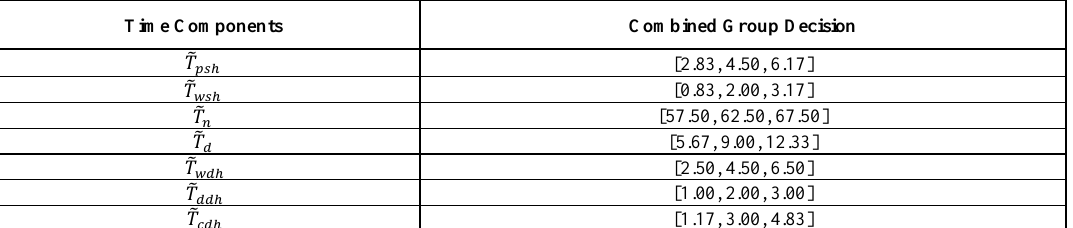
Table 2. Combined group decision TFN’s of travel time components.